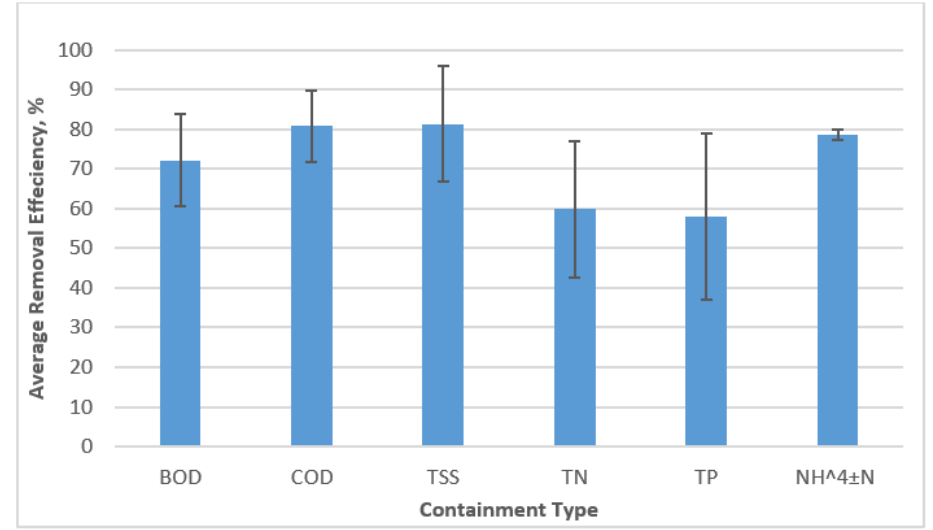
Figure 4. Horizontal flow site systems removal efficiency.